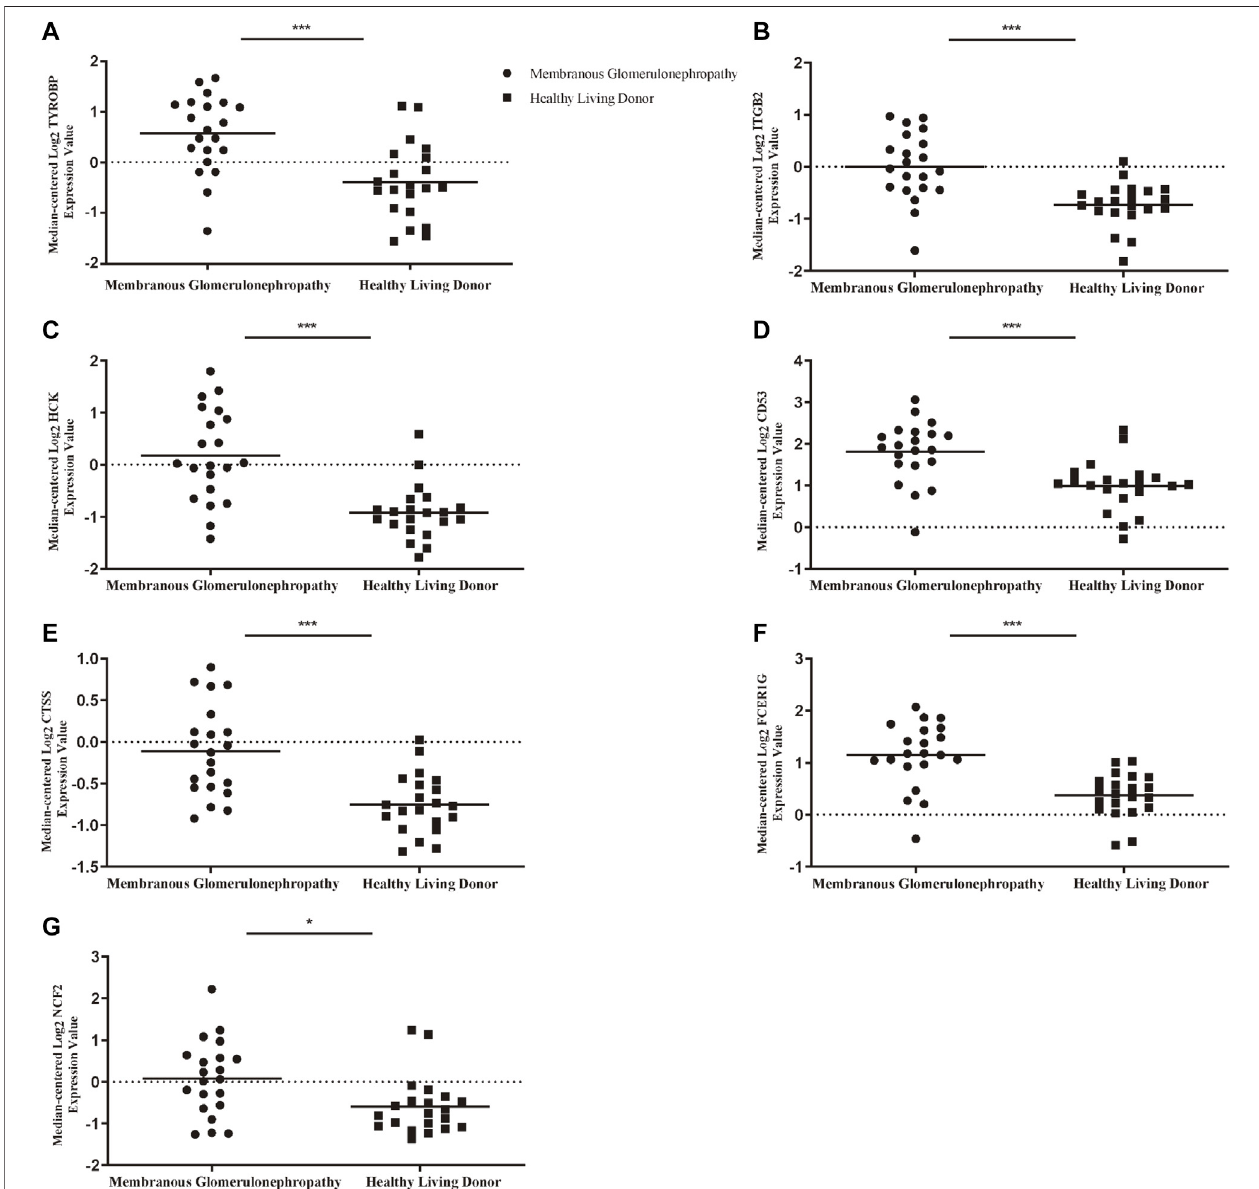
FIGURE5| AssociationbetweenmRNAexpressionofhubgenesinMNpatientsandnormalcontrols. (A) TheexpressionofTYROBPinMNgroupwashigherthan that of normal control (B) The expression of ITGB2 in MN group was higher than that of normal control. (C) The expression of HCK in MN group was higher than that